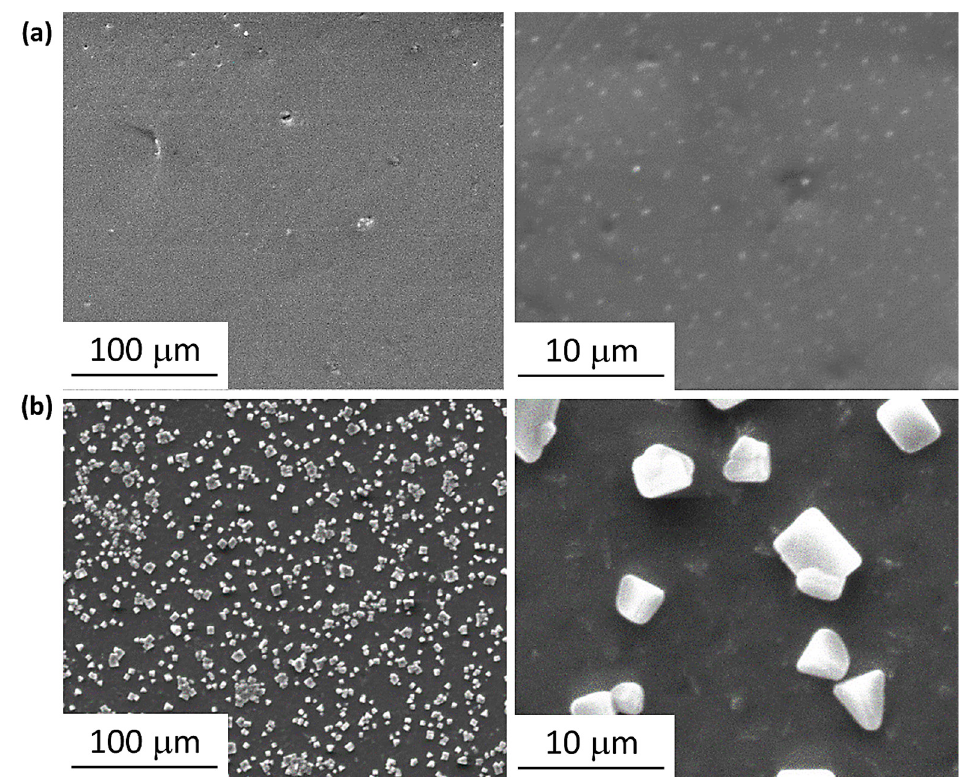
Figure 8. SEM Images of fi lms of ( a ): unblended PVC and ( b ): PVC containing clotrimazole after irradiation.